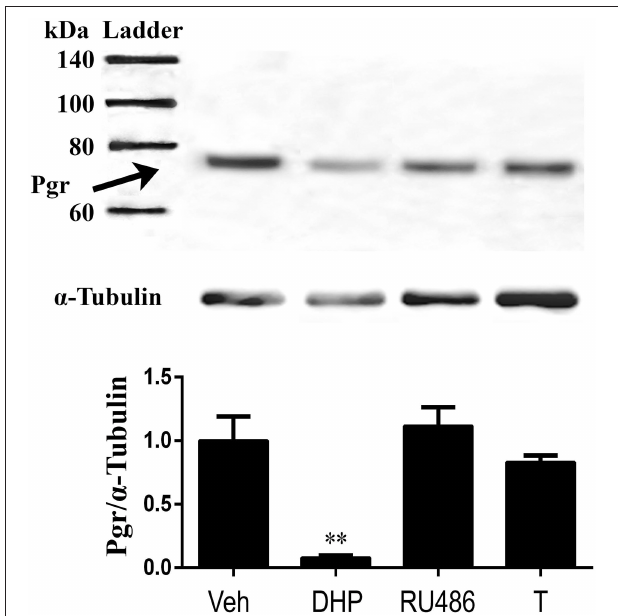
FIGURE 9 | Exposure of exogenous DHP significantly reduced Pgr protein, while RU486 or T exposure had no effect on Pgr protein expression in stage IVa follicles in zebrafish in vitro . (Top) Representative images of a Western blot of Pgr proteins following treatments. (Middle) Representative image of a Western blot analysis of α -tubulin that was used as an internal control for normalization of expression of Pgr protein. (Bottom) Normalized Pgr expression in each treatment compared to vehicle control. Asterisks indicate significant difference compared to vehicle treatment. Experiment was repeated three times with results of one representative experiment presented as mean ± SEM. ** p < 0.01.